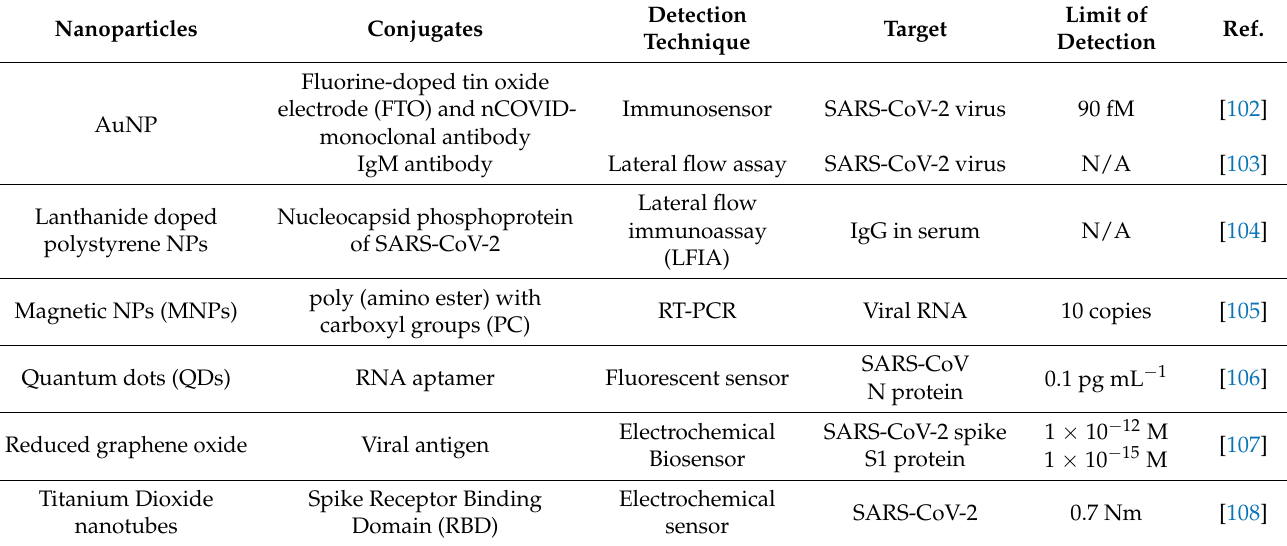
Table 1. Nanoparticles used for diagnosis of